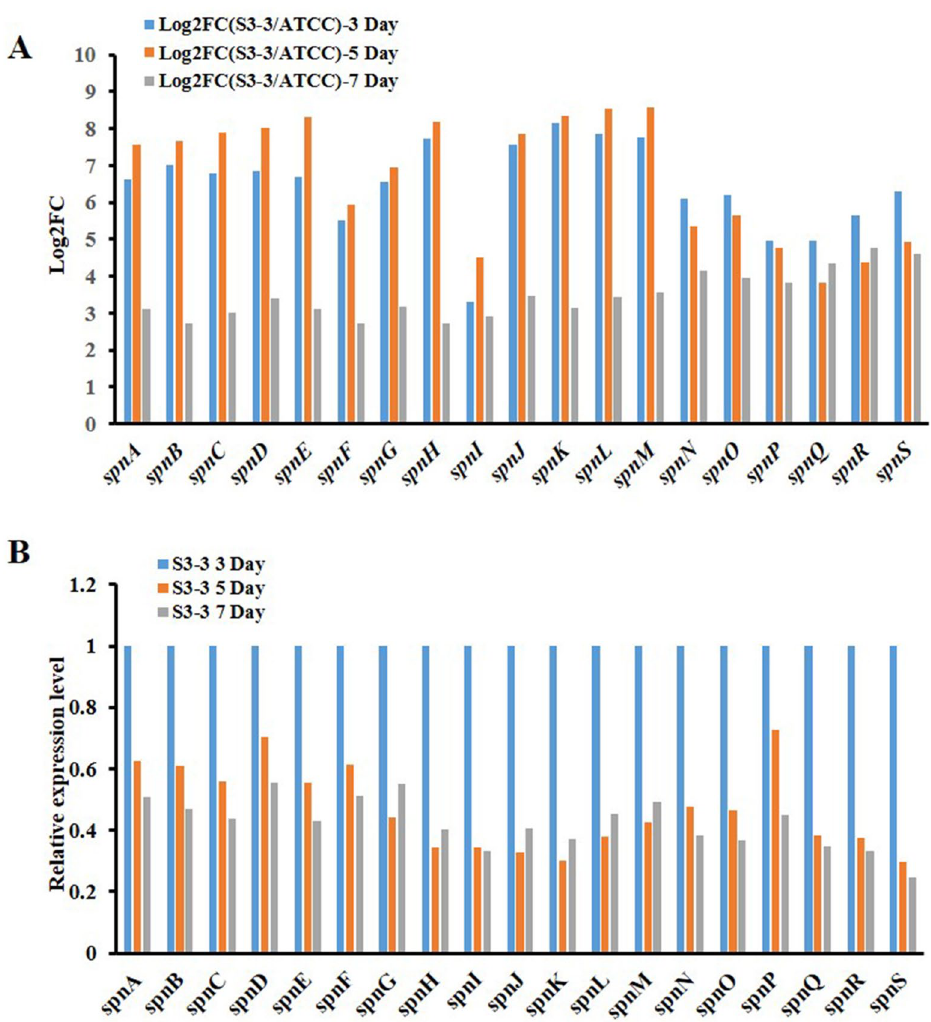
Figure 4. Transcriptional analysis of spinosyns synthesis genes in S. spinosa S3-3. ( A ) The expression differences of genes located in spinosyns biosynthetic gene cluster between S. spinosa ATCC_49460 and S. spinosa S3-3. The expression level of genes in S. spinosa ATCC_49460 was set as 1. ( B ) The expression differences of genes located in spinosyns biosynthetic gene cluster between different time points in S. spinosa S3-3. The expression level of genes at 3 day was set as 1. (The chart was carried out using Microsoft Office Professional Plus 2013).